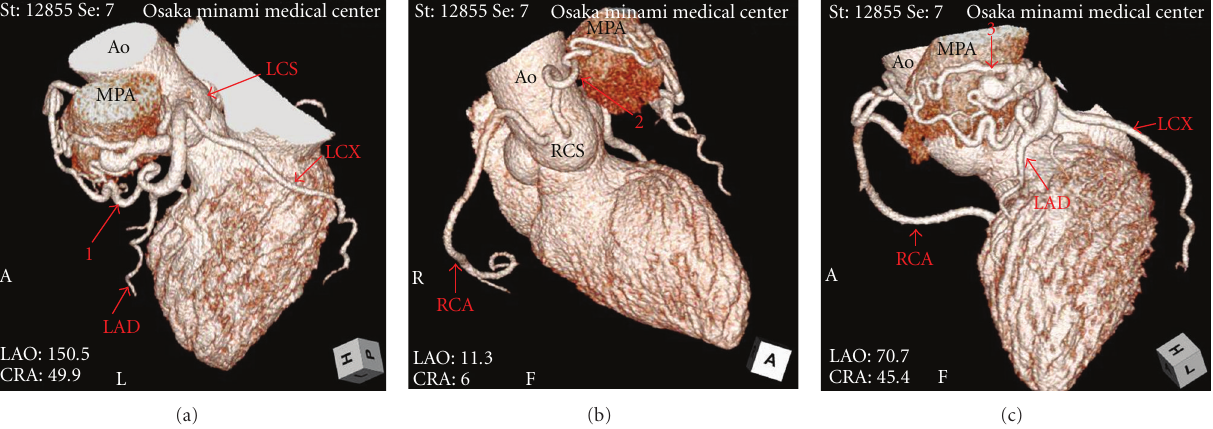
Figure 2: Three-dimensional volume-rendered images revealed the network of aberrant arteries arising from both left anterior descending coronary artery and right coronary sinus. Ao = ascending aorta, LAD = left anterior descending artery, LCS = left coronary sinus, LCX = left circumflex artery, MPA = main pulmonary artery, RCA = right coronary artery, RCS = right coronary sinus, 1 = the aberrant artery from left anterior descending coronary artery, 2 = the aberrant artery from right coronary sinus, 3 = the network of the aberrant